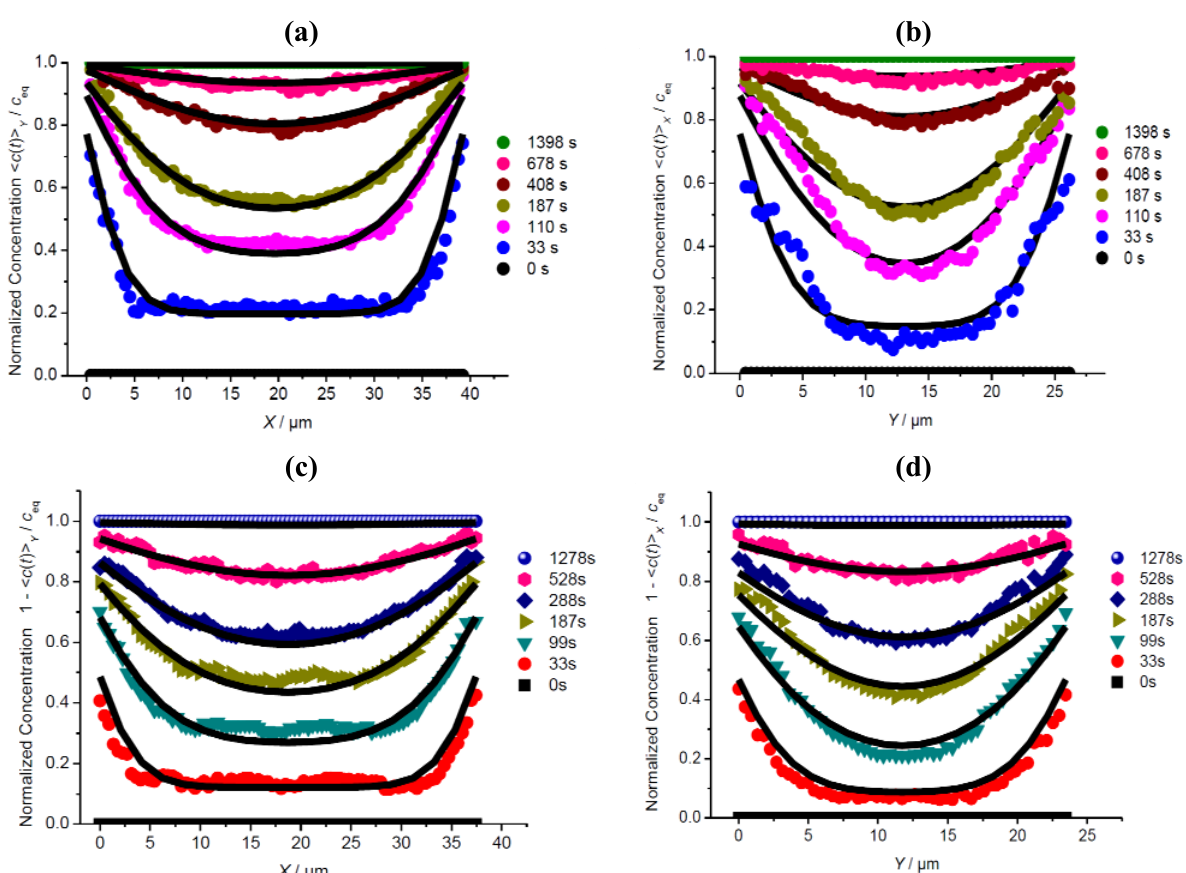
Figure 3. Profiles of mean concentrations during uptake ( a , b ) and release ( c , d ) of methyl-butane observed perpendicular to the XZ plane along X ( a , c , Figure 1b, Scheme 1, central line) and perpendicular to the YZ plane along Y ( b , d , Figure 1b, Scheme 2) and comparison with the solution of Fick’s 2nd law with the diffusivities and surface permeabilities given in Table 1 (solid